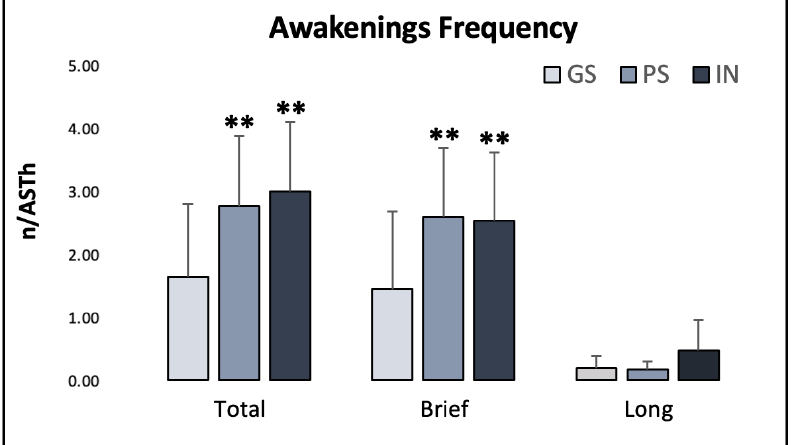
Figure 2. Frequency of total, brief and long awakenings in the three groups. AST: actual sleep time. Asterisks indicate significant differences relative to the GS group (**: p ≤ 0.01). Error bars represent standard deviation.